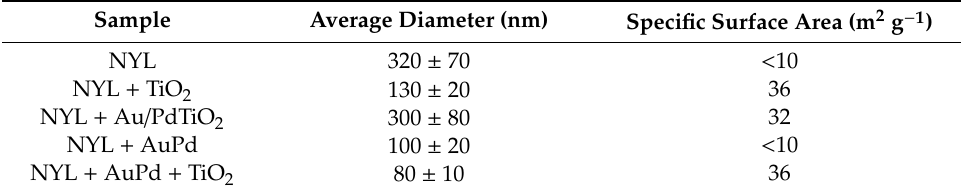
Table 2. NYL-based membranes: fiber average diameter and specific surface area of the electrospun